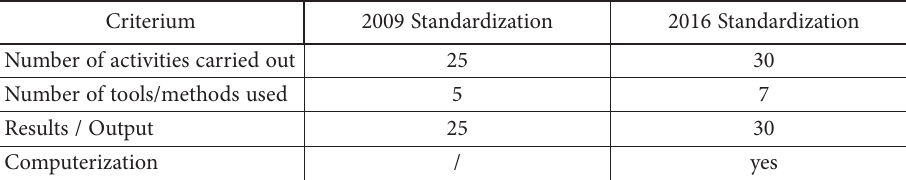
Table 1. Comparison of the degree of standardization in 2009 and 2016